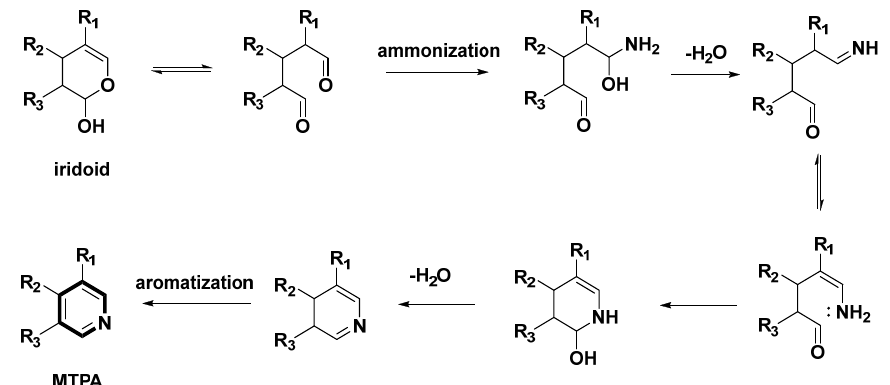
Scheme 2. Possible ammonization and aromatization pathway from iridoids to